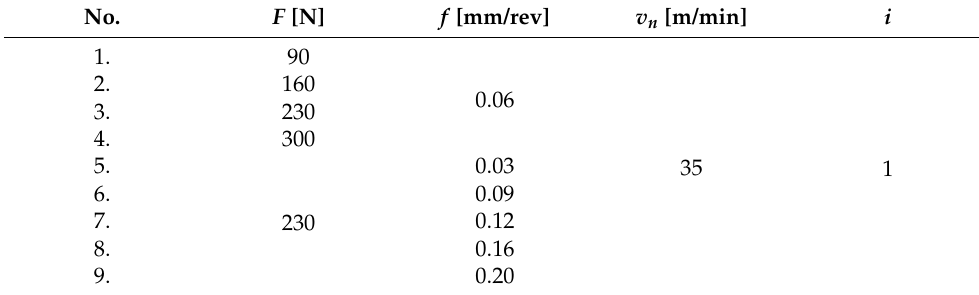
Table 2. Technological parameters of slide burnishing (F: slide burnishing force; f: feed, v n : burnishing speed; i : number of